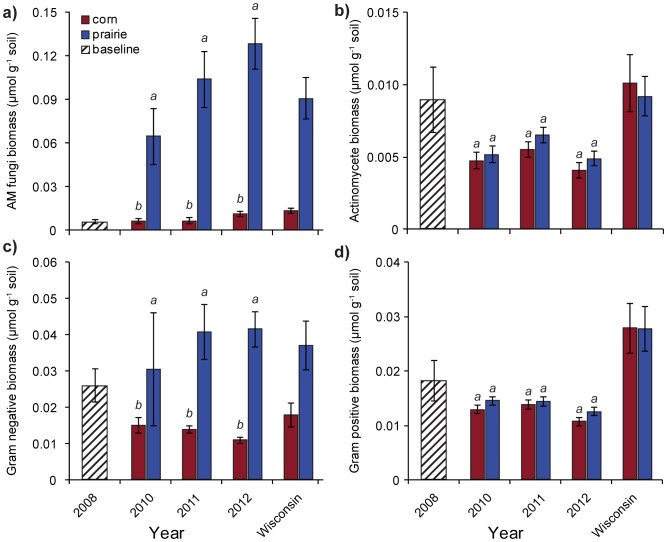
Absolute abundance of microbial functional group lipid biomarkers: (A) arbuscular mycorrhizal fungi; (B) actinomycetes; (C) Gram-negative bacteria; (D) Gram-positive bacteria.Baseline data adapted from Liang et al. [18], statewide Wisconsin data adapted from Liang et al. [12] based on observations from 2008. Bars are ±1 standard error. Groups sharing a letter are not significantly different at a P<0.05 significance level.